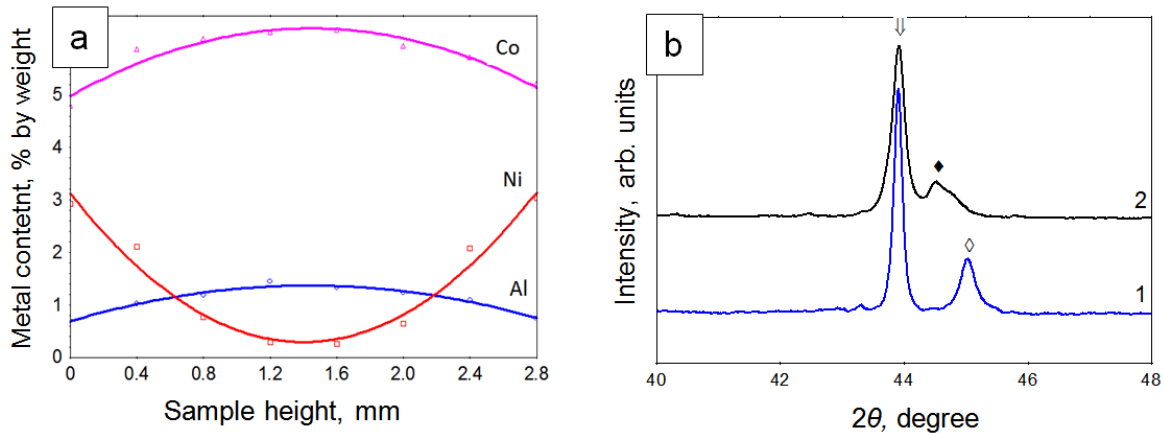
Figure 4. ( a ) Concentration profiles for the FDM-2Al- 6Сo sample infiltrated with Ni ( — 111 dia-